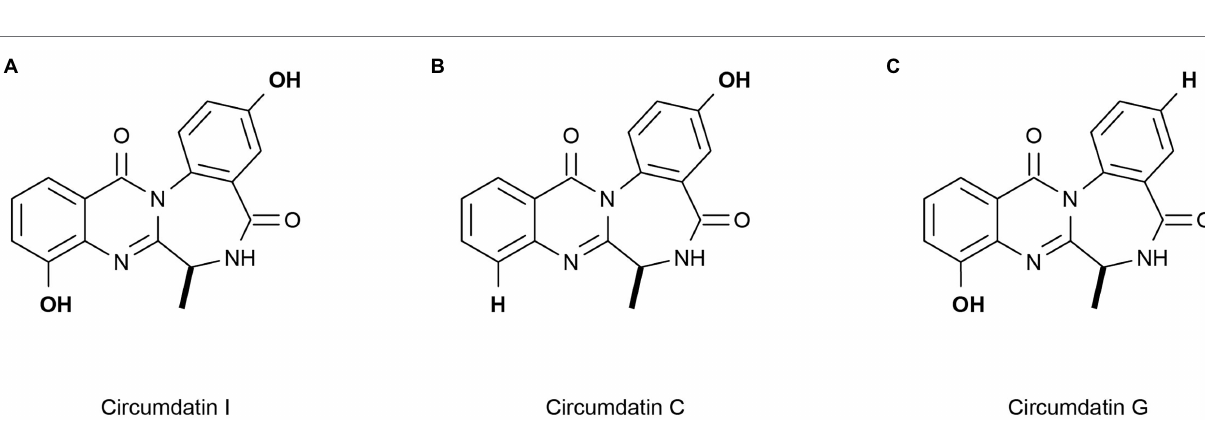
FIGURE 3 | Reprinted with the kind permission of The Journal of Antibiotics publications. Chemical structures of Circumdatin I (A) , C (B) , and G (C) . Adapted from Zhang et al.